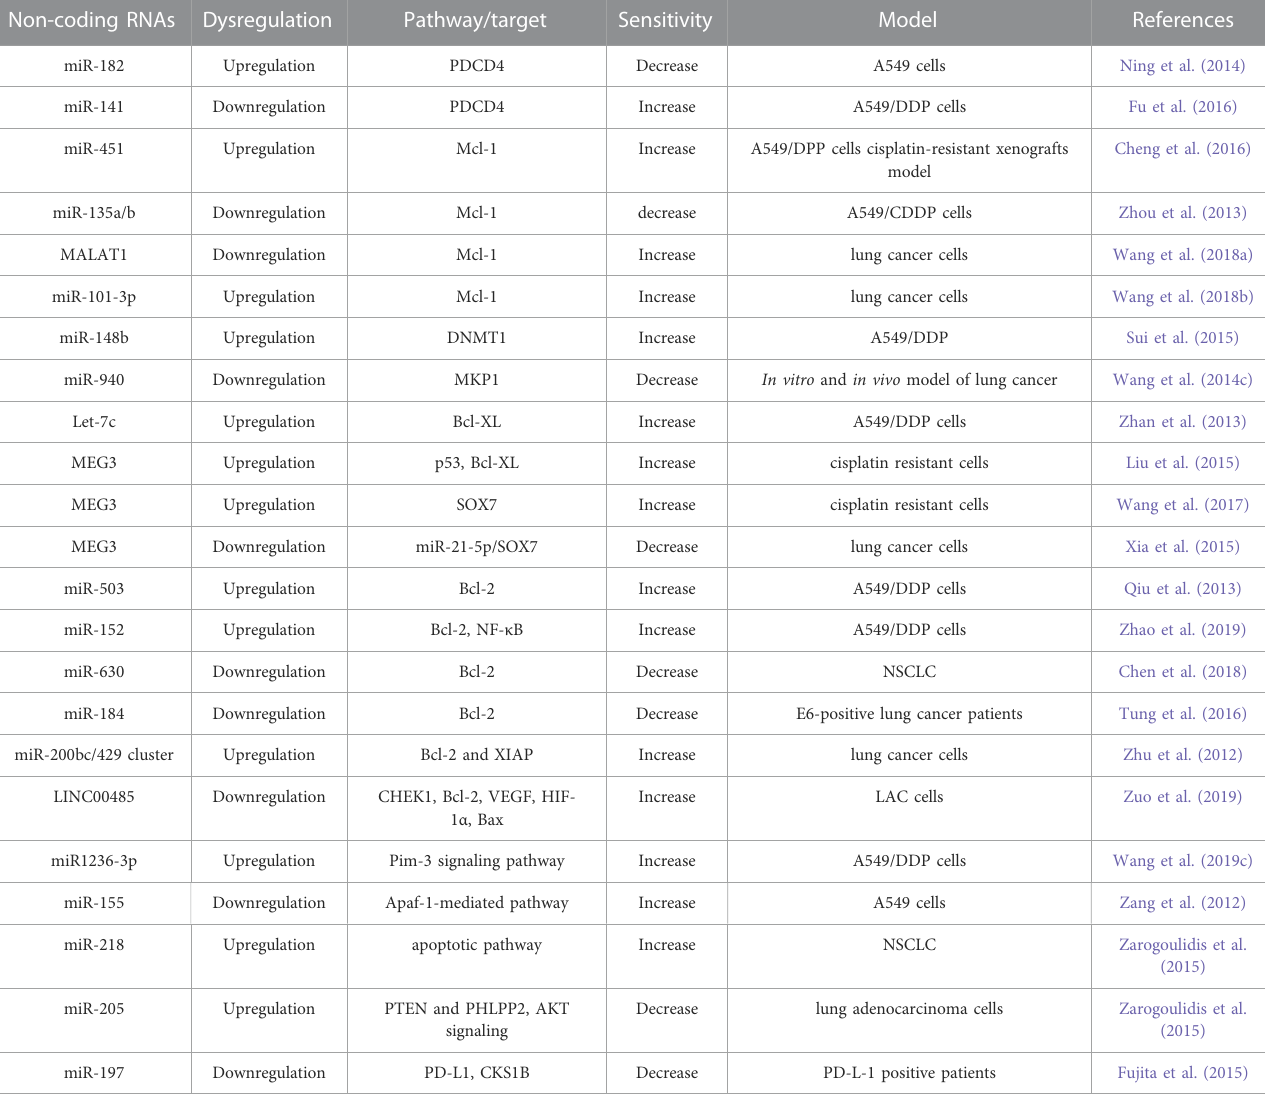
TABLE 3 Dysregulation of ncRNAs alters the expression of apoptotic markers involved in cisplatin-resistance. Non-coding